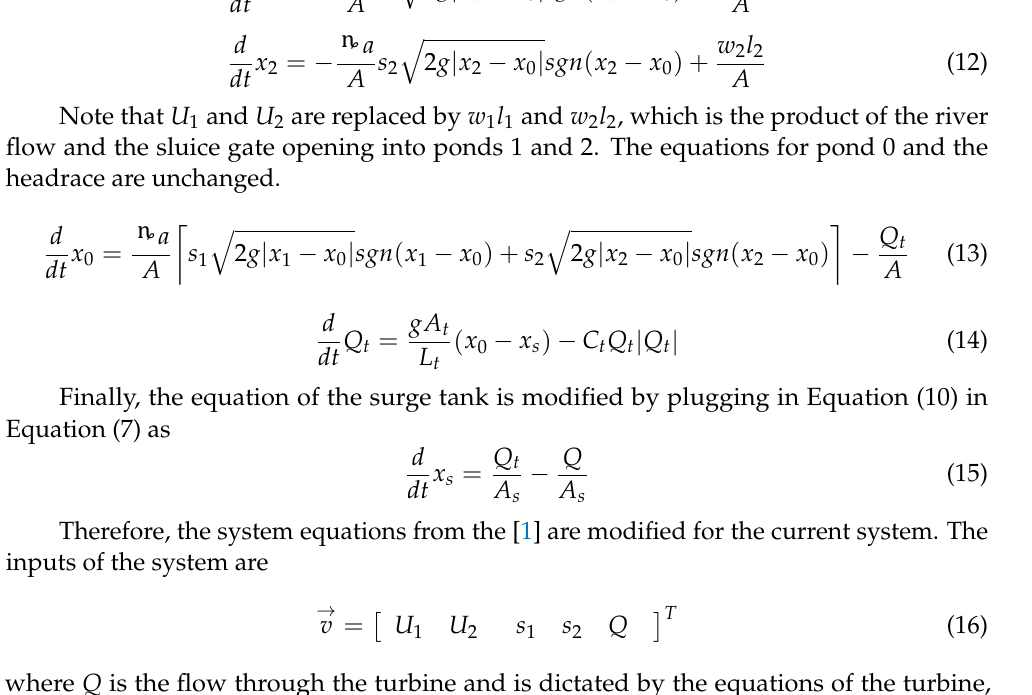
Figure 1. Three-pond hydraulic